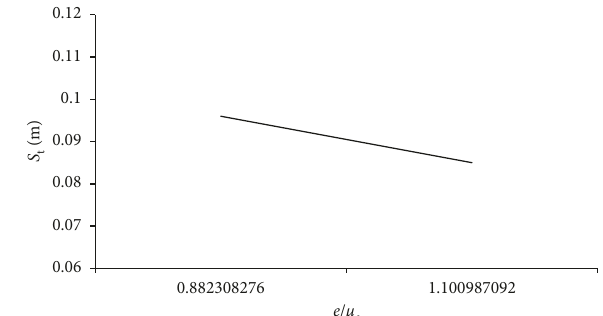
Figure 4: Effect of void ratio on final consolidation